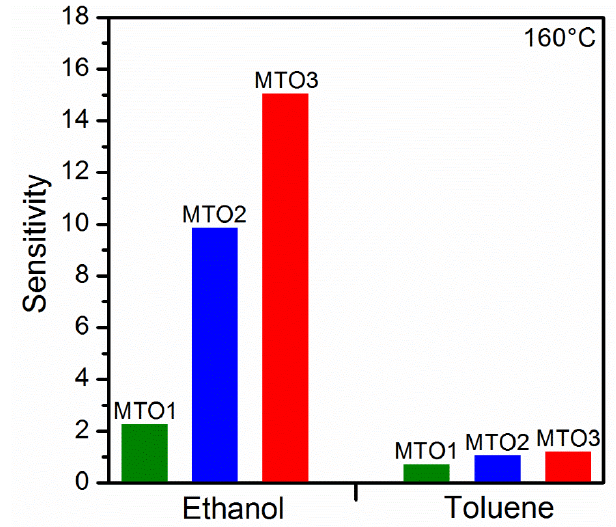
Figure 11. Sensitivity of the Mg-doped SnO 2 films to ethanol and toluene. Sensors 2020 , 20 , x FOR PEER REVIEW